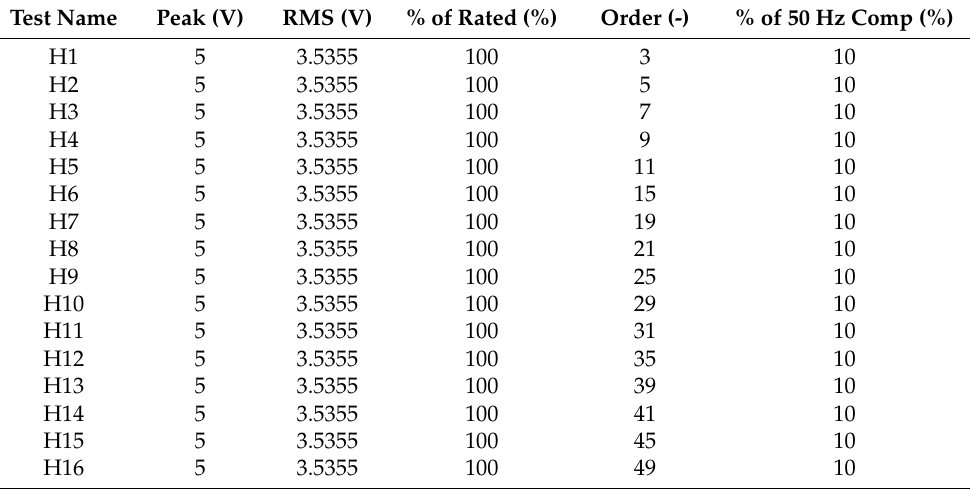
Table 13. Settings of the harmonic